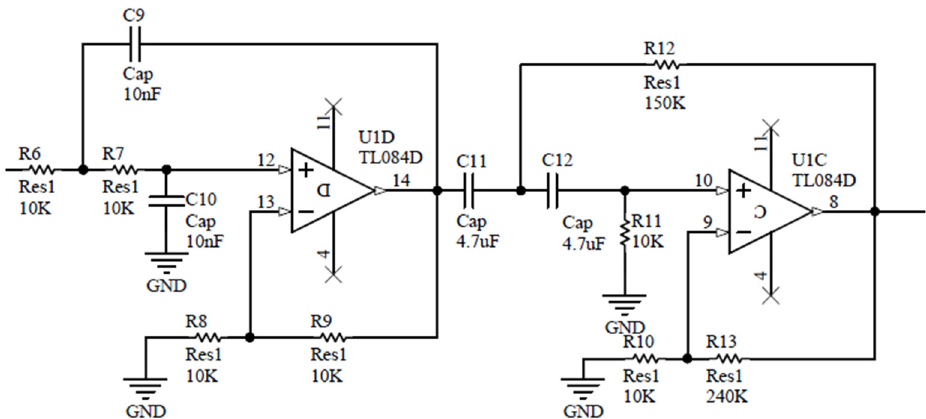
Figure 11. Schematic diagram of low and high-pass filter and amplifier circuit.